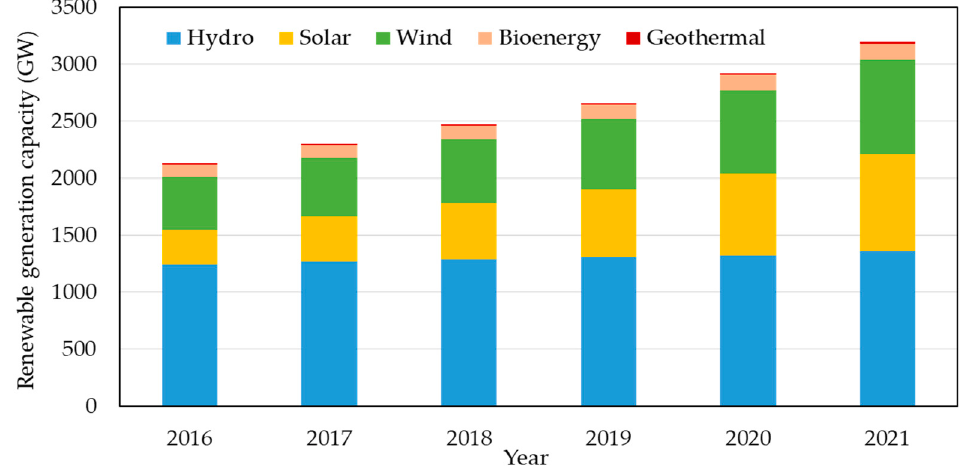
Figure 1. Renewable sources-based power generation capacity growth worldwide.